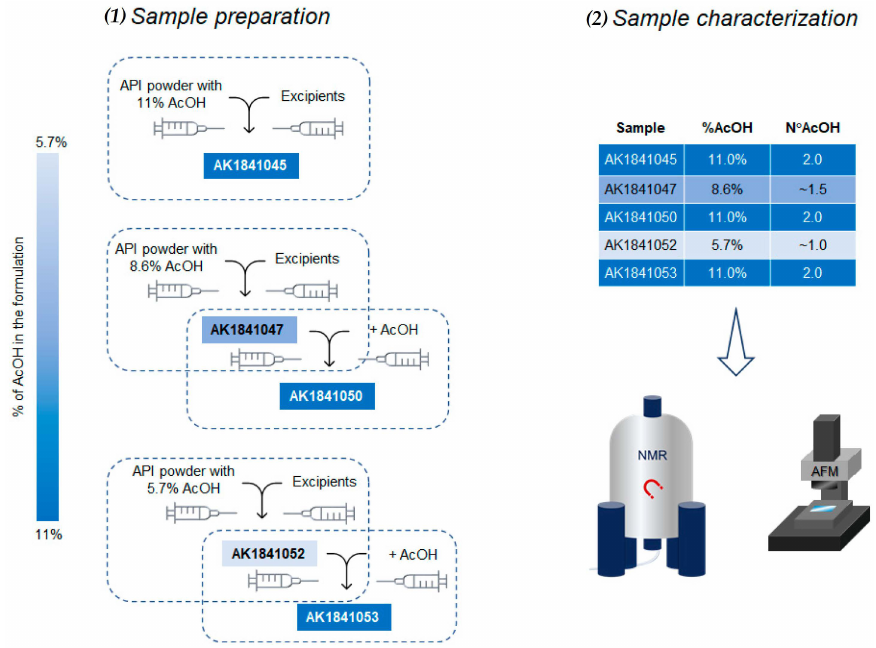
Figure 2. Schematic representation of ( 1 ) preparation of Somatuline analogs with different amounts of AcOH as indicated by the color bar on the left, and ( 2 ) the techniques applied for the characterization of supramolecular structures assumed by the obtained